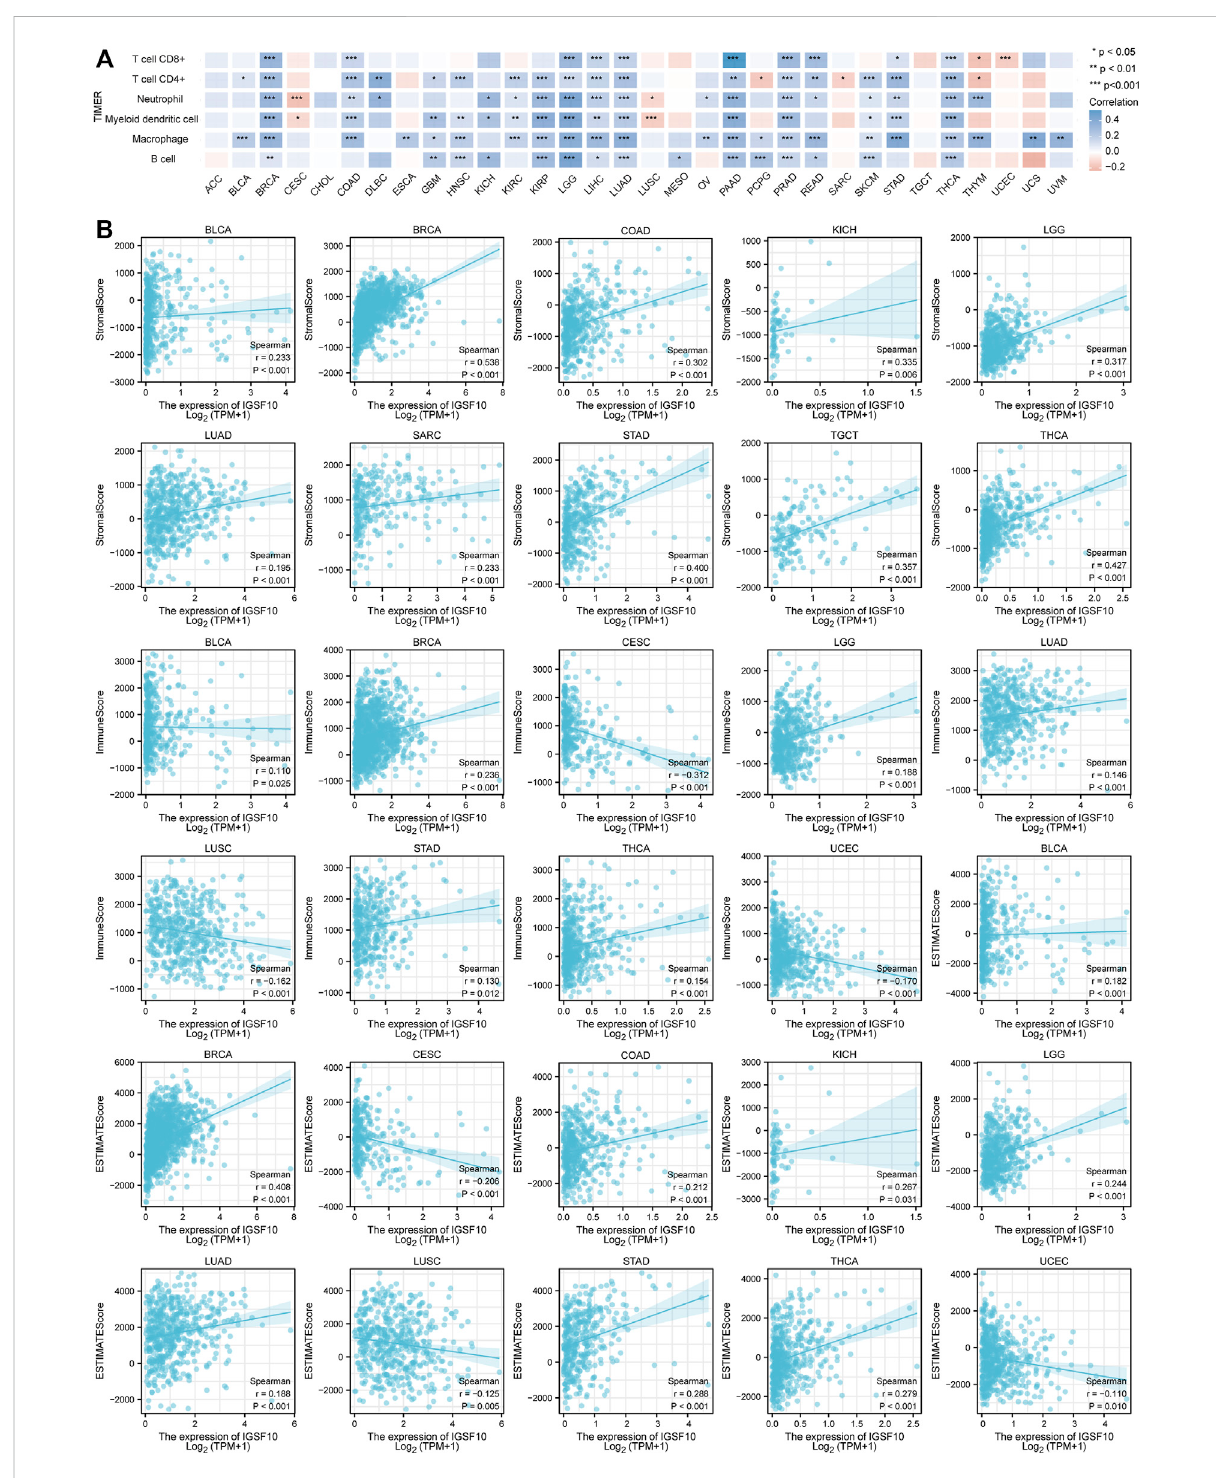
FIGURE 7 IGSF10 expression was associated with cancer immunity. (A) Relationships between IGSF10 expression and immune cell in fi ltration in different cancers. * p < 0.05, ** p < 0.01, *** p < 0.001. (B) The correlations of IGSF10 expression with the stromal score, immune score and ESTIMATE score in various